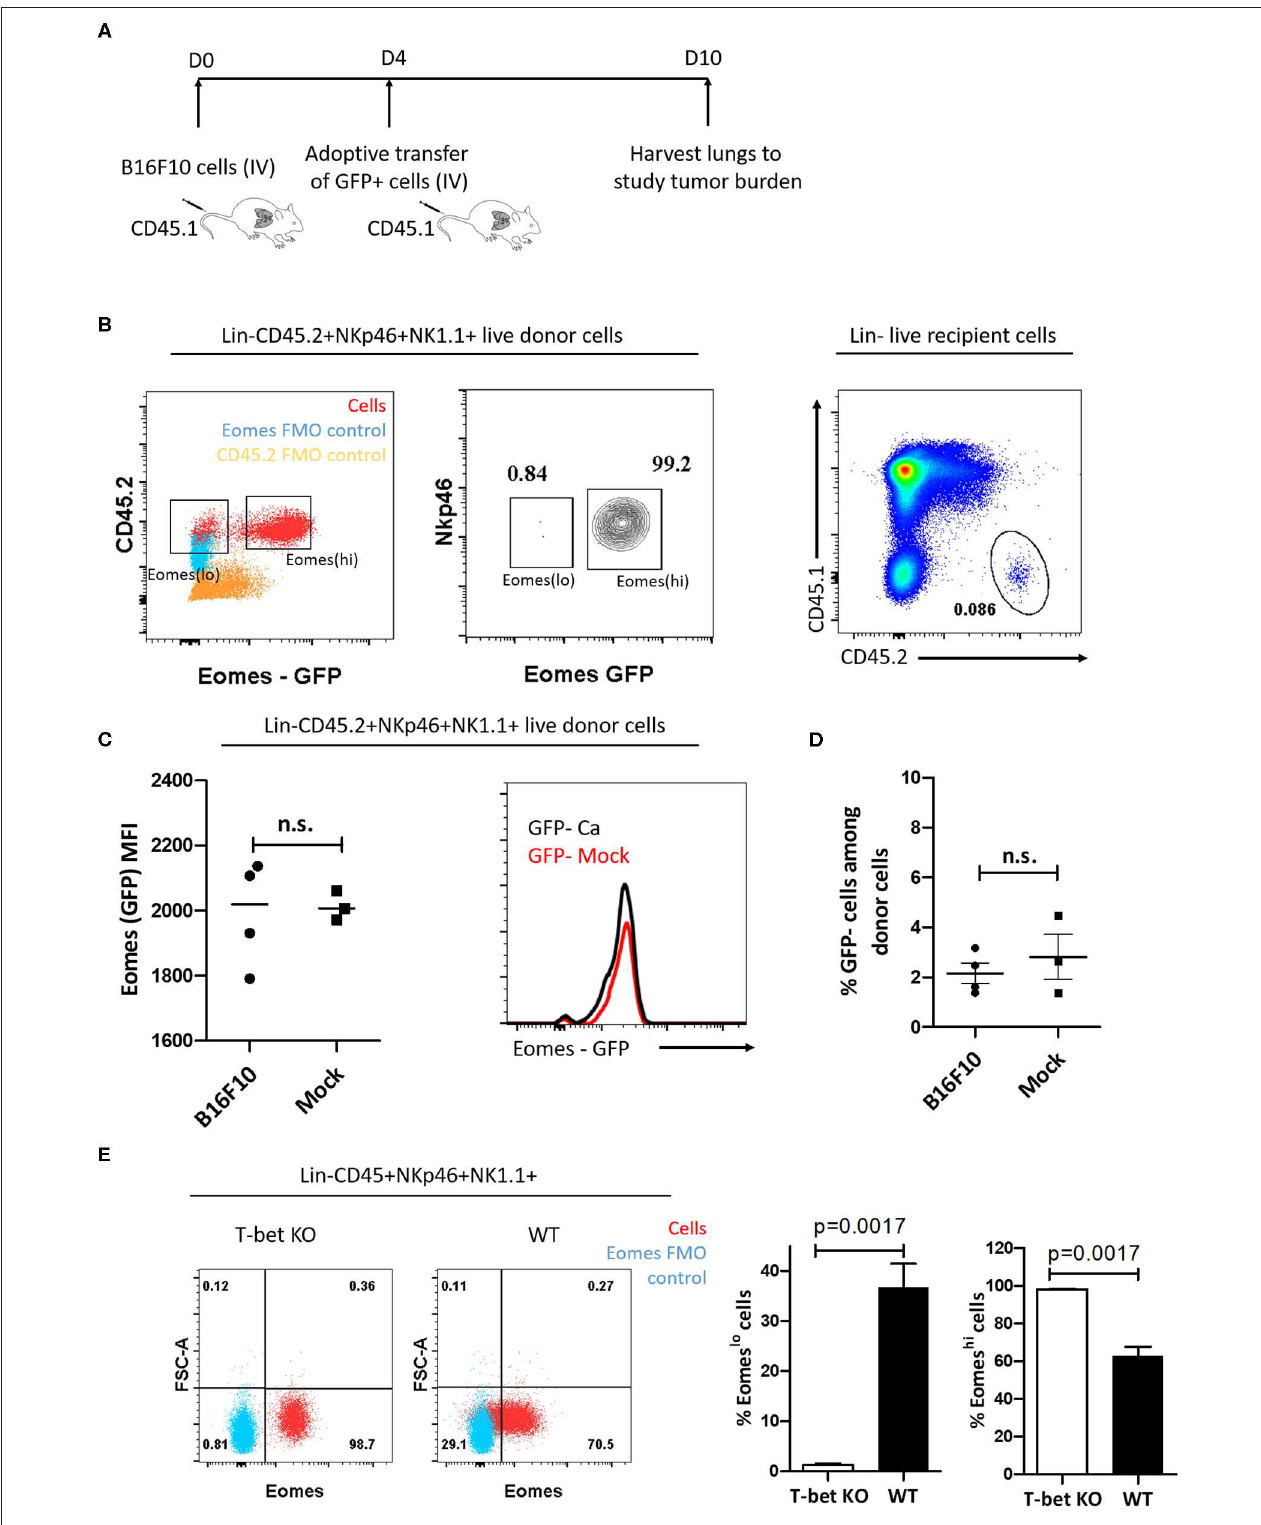
FIGURE 3 | Eomes lo and Eomes hi subsets correspond to different cell lineages. (A) Scheme of adoptive transfer of Eomes hi cells into CD45.1 mice bearing cancer (relative to mock). After injection of B16F10 cells (day 0), Eomes hi cells were harvested from donor Eomes-GFP mice and adoptively transferred into recipient mice